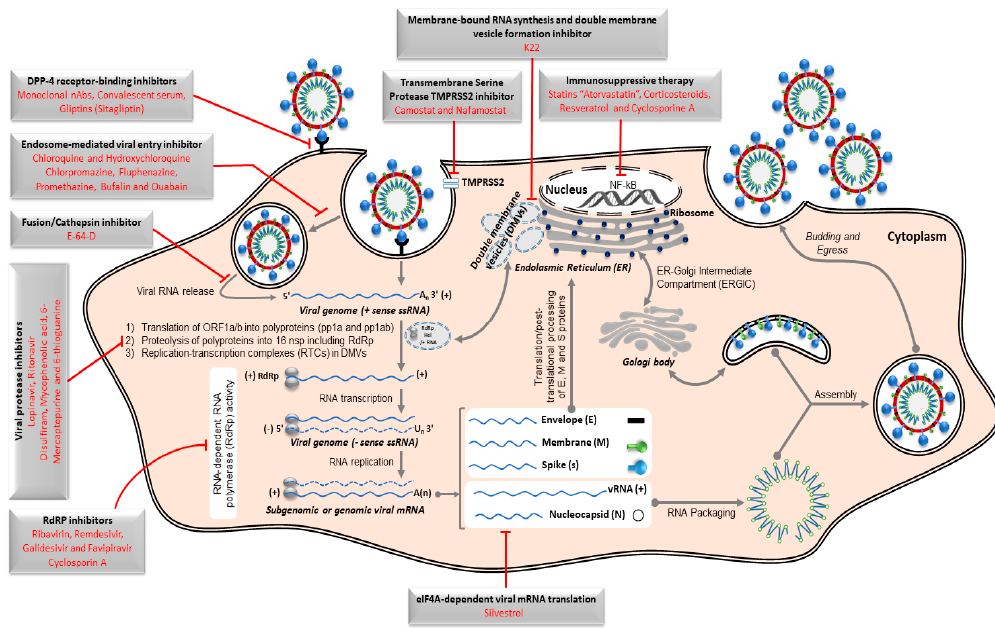
Figure 4. Schematic representation of Middle East respiratory syndrome coronavirus (MERS-CoV) replication cycle and key targets for antiviral activity. The spike protein of MERS-CoV initiates host cell infection via binding its receptor-binding domain (RBD) in the S1 subunit into cellular receptor dipeptidyl peptidase 4 (DPP4), originally known as the lymphocyte cell surface protein CD26. Following binding, the viral particle in the form of an endosome internalizes into the cytosol via acid-dependent proteolytic cleavage of S protein by a cathepsin or TMPRRS2. To release the viral genome ( + ssRNA) into the cytoplasm, fusion of the viral and cellular membranes within acidified endosome occurs. Initially, the replicase gene, which encodes the largest two open-reading frames “ORF1a and ORF1ab”, is translated to express two co-terminal polyproteins, pp1a and pp1ab. These polyproteins are further cleaved by virus-encoded proteases “papain-like protease PLpro and 3C-like protease 3CLpro" into 16 mature nonstructural proteins (nsp) including viral polymerase subunits. Essential elements for viral genome replication are gathered as RNA replication–transcription complexes (RTCs) within the endoplasmic reticulum-derived double-membrane vesicles (DMVs). The RTCs drive the production of intermediate negative-sense viral genome (–ssRNA) transcript. During replication, the –ssRNA genome is used as a template for generating nascent + ssRNA. Along with the continuous transcription to generate the nascent full-length coding + ssRNA, sub-genomic RNAs, including those encoding all essential structural proteins (spike (S), envelope (E), membrane (M), and nucleocapsid (N)), are produced via discontinuous transcription. Nucleocapsid and nascent genomic RNA are assembled together in the cytoplasm and further transported into the lumen of the endoplasmic reticulum (ER)–Golgi intermediate compartment (ERGIC). Meanwhile, the S, E, and M sub-genomic RNAs are translated and inserted into the membrane of the rough endoplasmic reticulum (ER), from where they are transported to interact with RNA-encapsidated N proteins in the ERGIC, forming a mature viral particle. Via exocytosis, the nascent viral particle is then released from the infected cell. The repurposed therapeutic drugs undergoing preclinical and clinical trials against MERS-CoV in the context of host pathways and virus replication mechanisms are represented in the figure. The symbol (cid:97) refers to